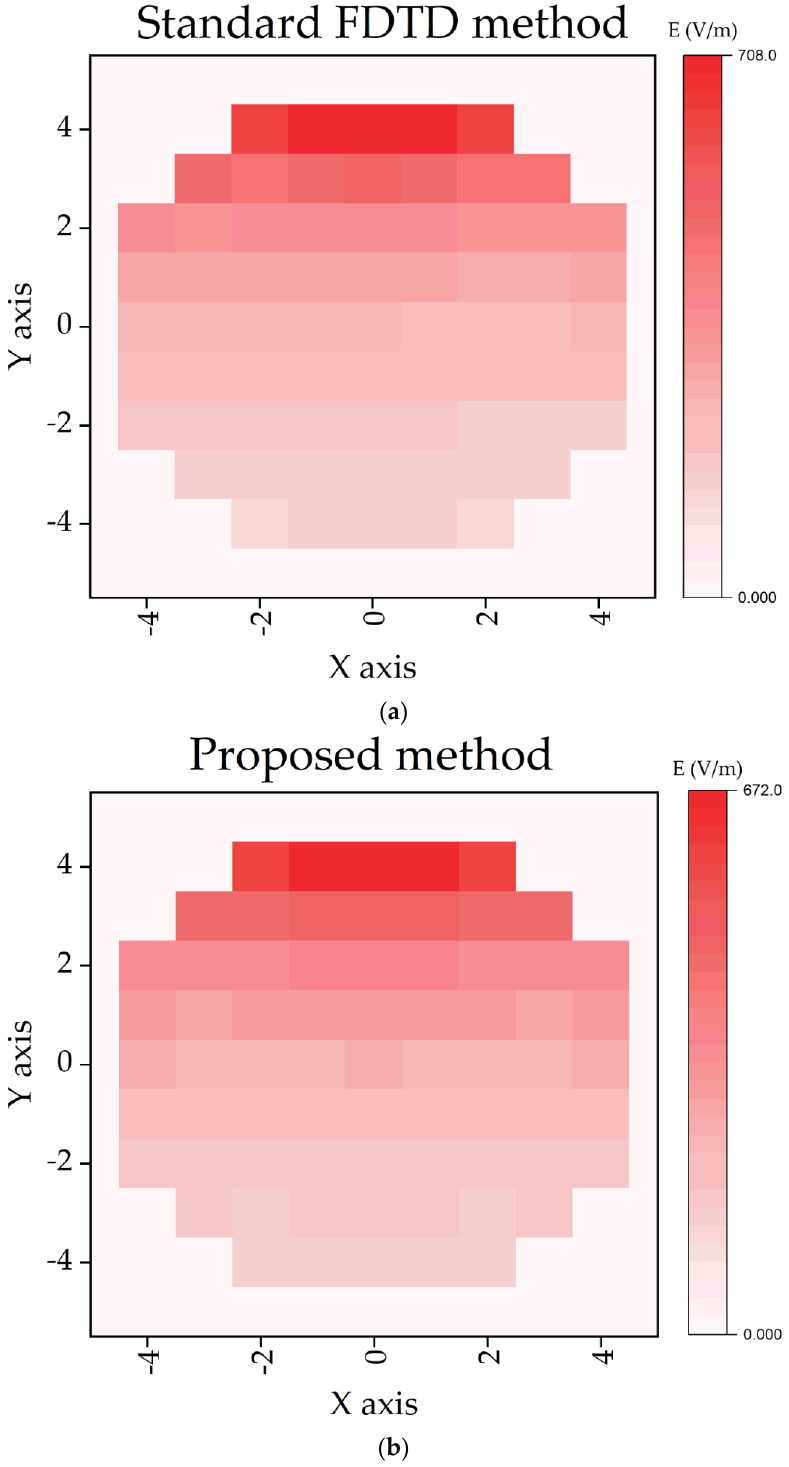
Figure 6. Induced electric field distribution in the plane z = 0 from Hertzian electric dipole: ( a ) Standard FDTD method, ( b ) Proposed method.